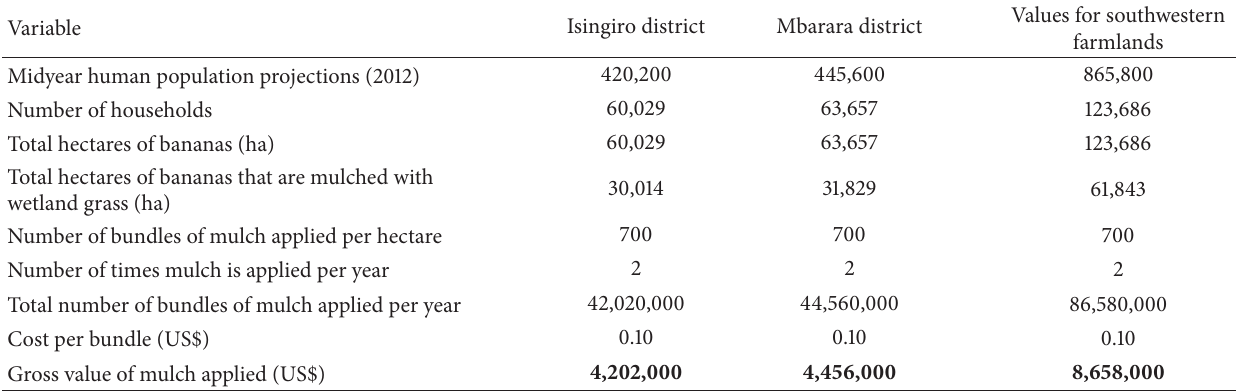
Table 5: Monetary contribution of wetland grass to food security through mulching bananas in the South western Farmlands agro-ecological